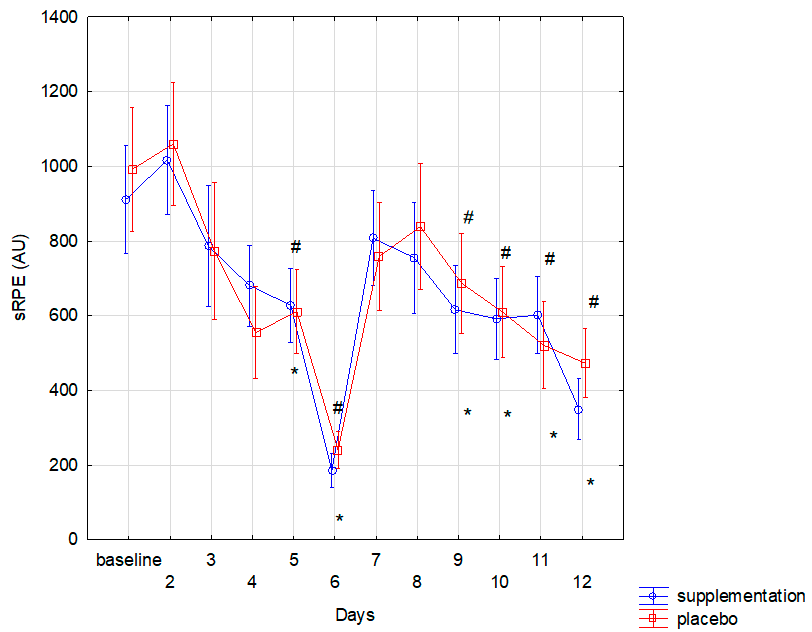
Figure 1. The changes of session Rating of Perceived Exertion (sRPE) during training in group with supplementation and with placebo (* significant change ( p < 0.05) to baseline in placebo group; # significant change ( p < 0.05) to baseline in supplement group).